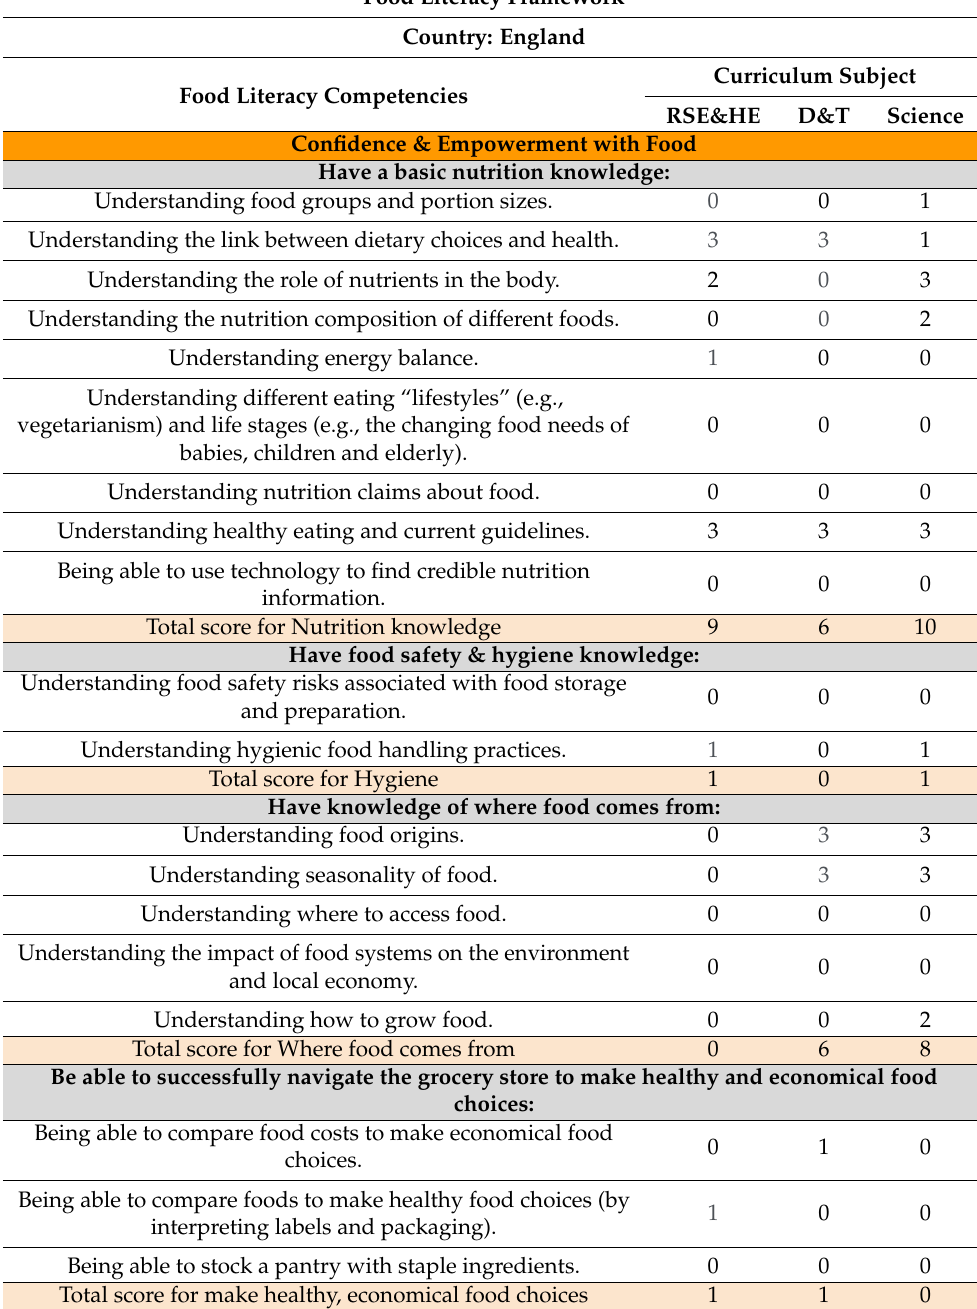
Table A2. Example of the food literacy framework scoring spreadsheet. Source: Authors. The framework is structured under Themes (1-3), which are divided into subgroups in grey. Each subgroup is made up of individual competencies. The total score for each subgroup was used to create graphs for analysis. Red competencies were added to the framework by the authors. In England, Relationships and Sex Education and Healthy Eating (RSE&HE), Design and Technology (D&T) and Science curriculums included food education. The red text indicates competencies added by the authors. Food Literacy Framework Country: England Curriculum Subject Food Literacy Competencies RSE&HE D&T